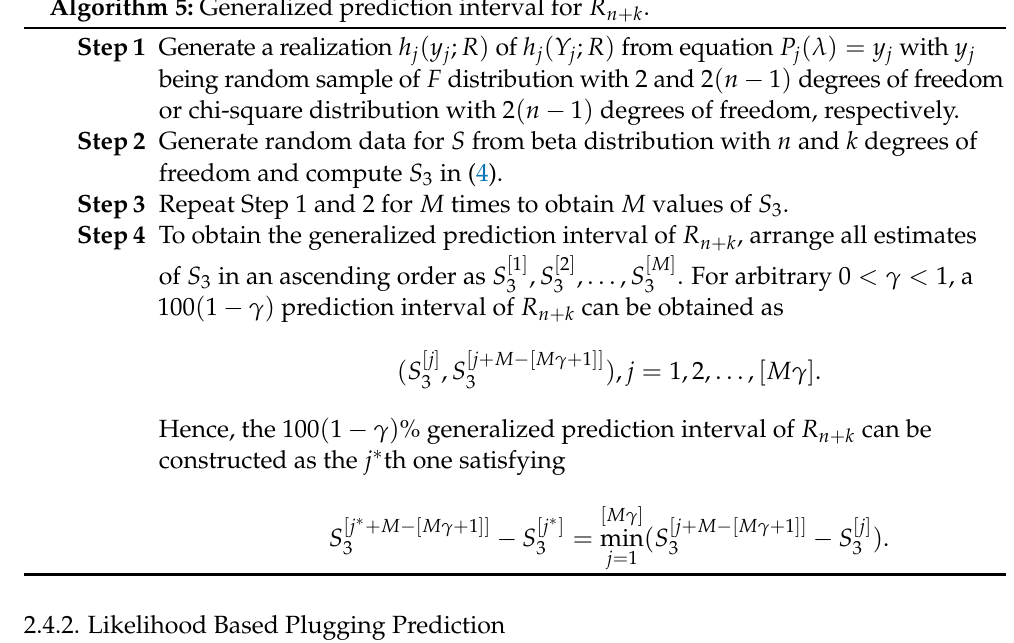
Algorithm 5: Generalized prediction interval for R n + k